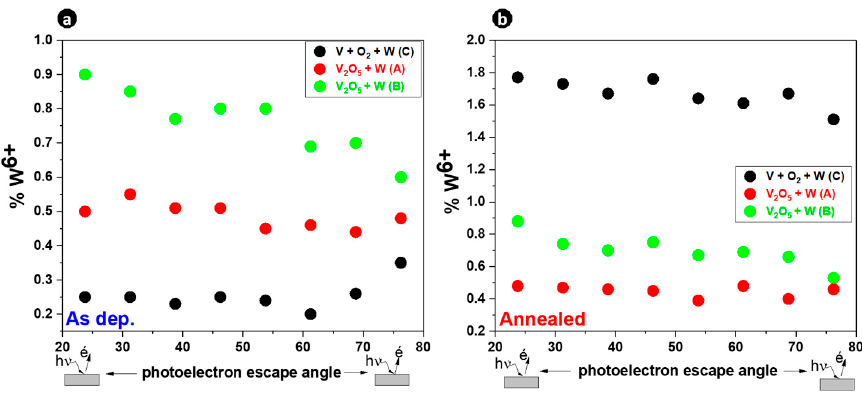
Figure 5. The proportion of W 6+ based on V 3p, W 4f, and O 2s as a function of the ARXPS detection angle for all the samples ( a ) before thermal annealing and ( b ) after thermal